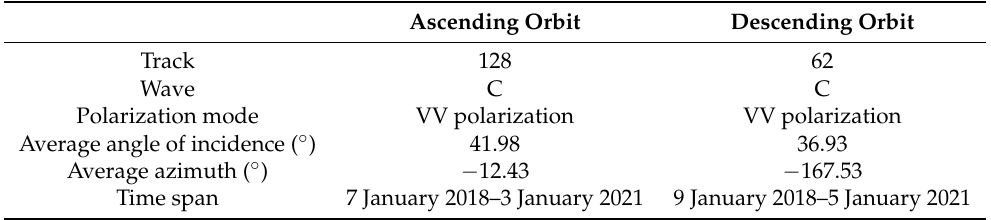
Table 1. Sentinel data parameters used in this study.